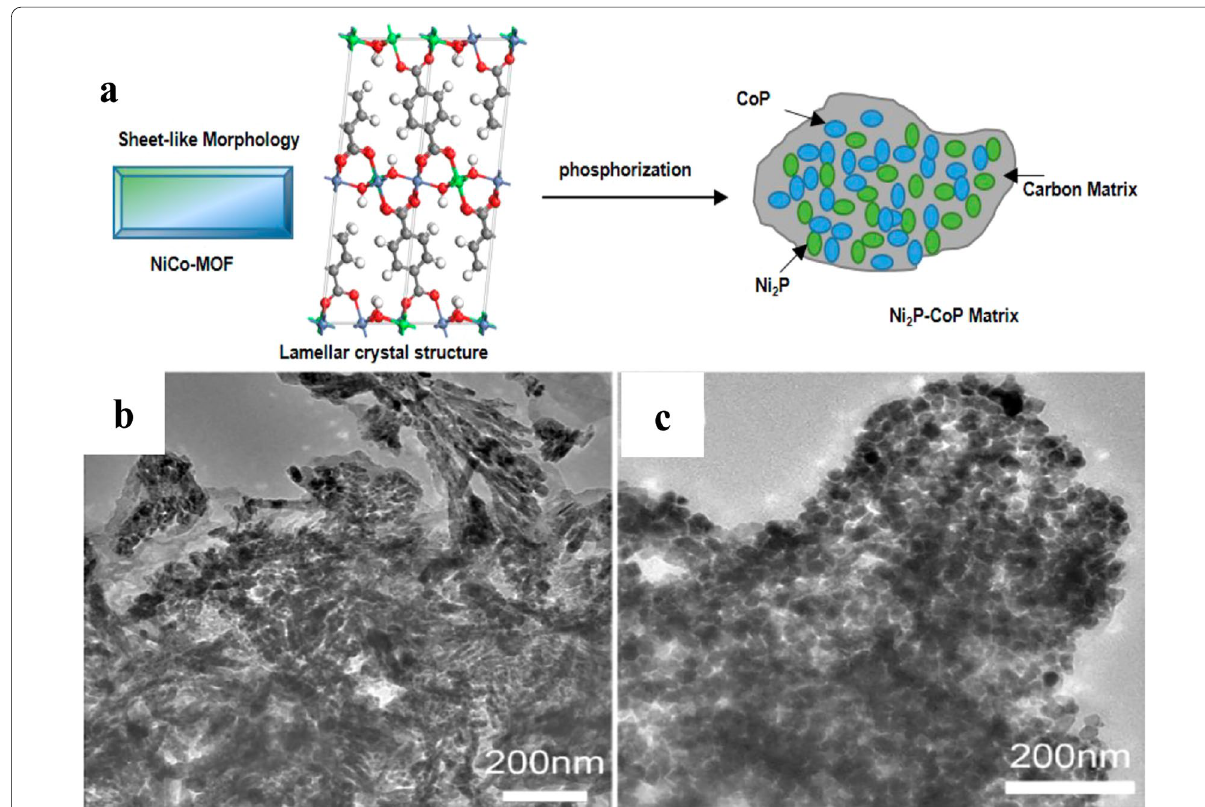
Fig. 5 a Schematic representation of the fabrication of Ni 2 P respectively. Reproduced with permission from Ref. [44]. Copyright 2015, American Chemical